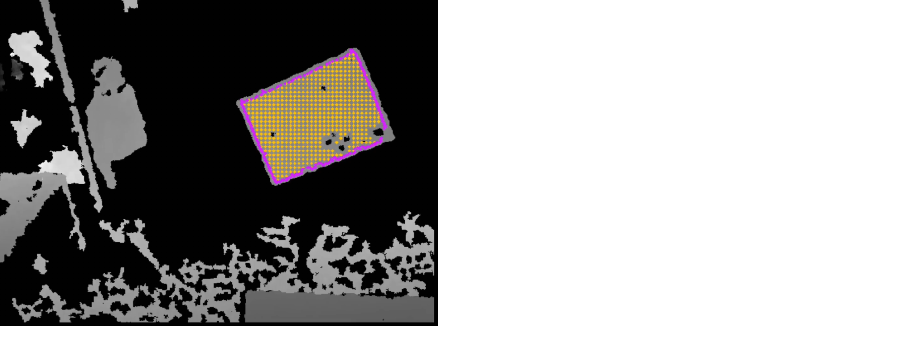
Figure 9. Labeling of depth camera data, with yellow pixels as detections and magenta pixels as boundary pixels.